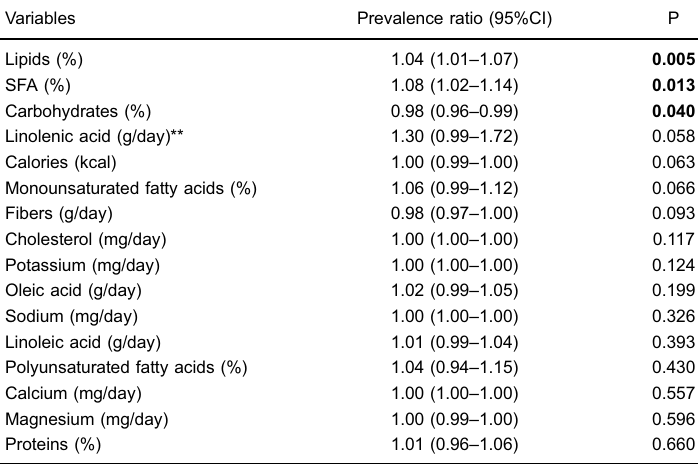
Table 4. Modi fi ed Poisson regression to evaluate independently associated dietary-intake factors with moderate/severe coronary artery calci fi cation (CAC).